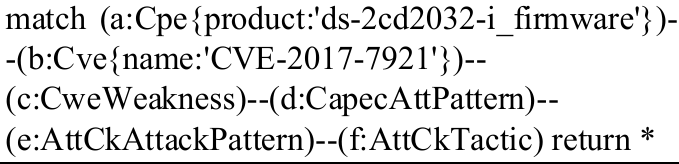
Figure 5. Cypher query for CVE-2017-7921.